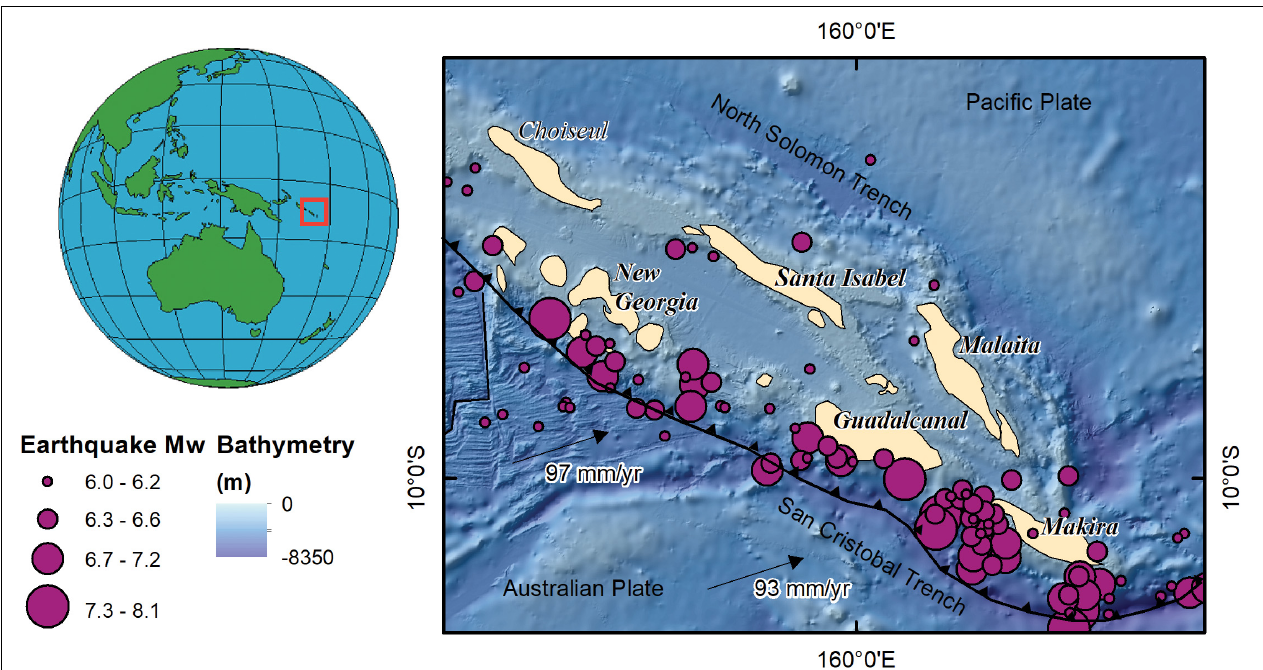
FIGURE 1 | Plate tectonic setting of the Solomon Island Arc with the islands of Guadalcanal and Makira forming the southernmost major islands with Mw > 6 earthquakes for the period 1980 to present shown (USGS, 2019). Bathymetric data is the GEBCO_2019 Grid (GEBCO Compilation Group 2019). Plate velocities from Chen et al.